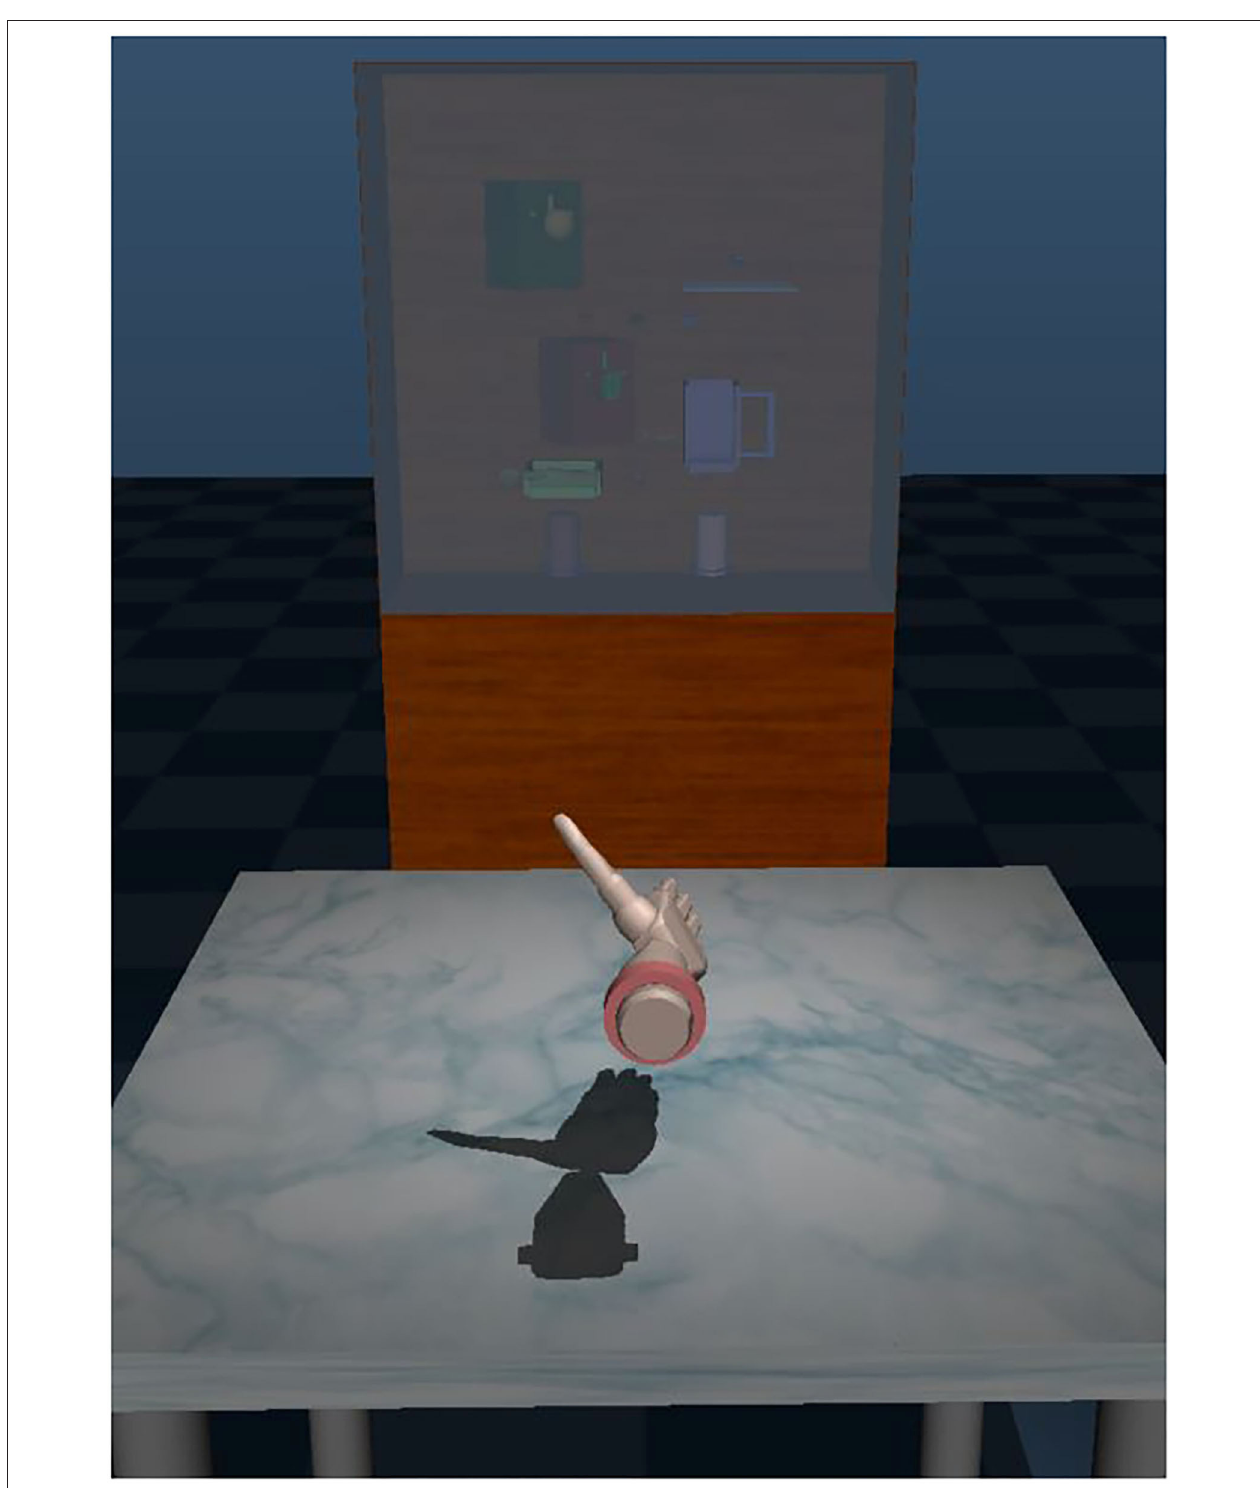
FIGURE 1 | The virtual environment, Multi-Joint dynamics with Contact (MuJoCo) Hand Proprioceptive, and Touch Interfaces (HAPTIX).